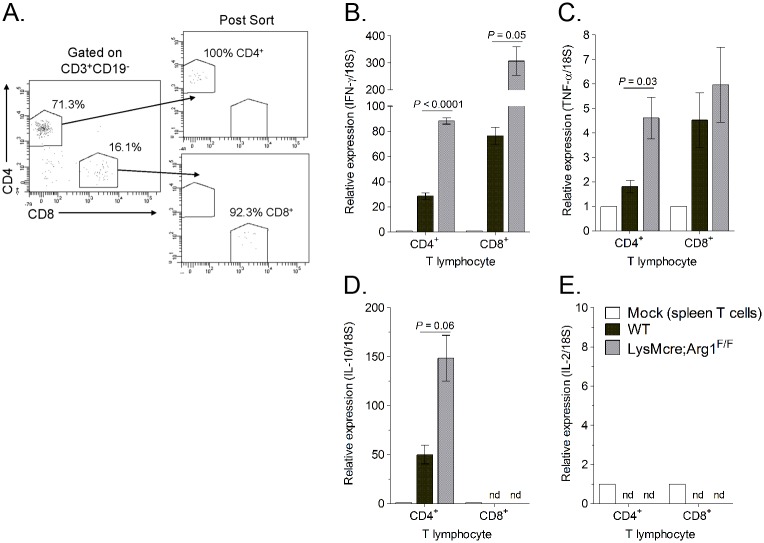
Muscle-infiltrating CD4+ and CD8+ T cells isolated from LysMcre;Arg1F/F mice express enhanced IFN-γ transcript.(A) Representative flow plots demonstrating the gating strategy to FACS-sort CD19-CD3+CD4+CD8- and CD19-CD3+CD8+CD4- T cells isolated from quadriceps muscles of RRV-infected WT or LysMcre;Arg1F/F mice at 10 dpi and the post-sort purities. RT-qPCR analysis of (B) IFN-γ, (C) TNF-α, (D) IL-10, and (E) IL-2 expression in FACS-sorted T cells from the spleen of a mock-inoculated mouse (n = 1) or from the quadriceps muscle of RRV-infected WT (n = 3) or LysMcre;Arg1F/F mice (n = 3) at 10 dpi. Data are normalized to 18S rRNA levels and are expressed as the relative expression (n-fold increase) over expression in spleen T cells from a mock-inoculated mouse. Data are represented as the arithmetic mean ± SEM. Data are representative of two independent experiments. P-values determined by two-tailed, unpaired t-tests with or without Welch’s correction. nd, not detected.